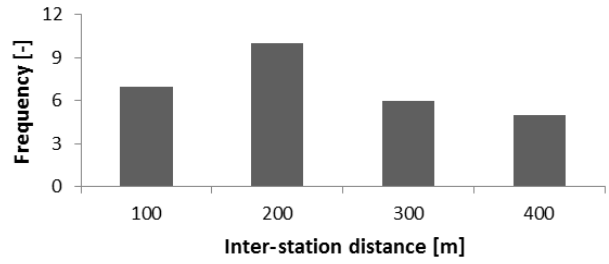
Figure 2. Histogram with class interval width of 100m showing frequency distribution of inter-station distances